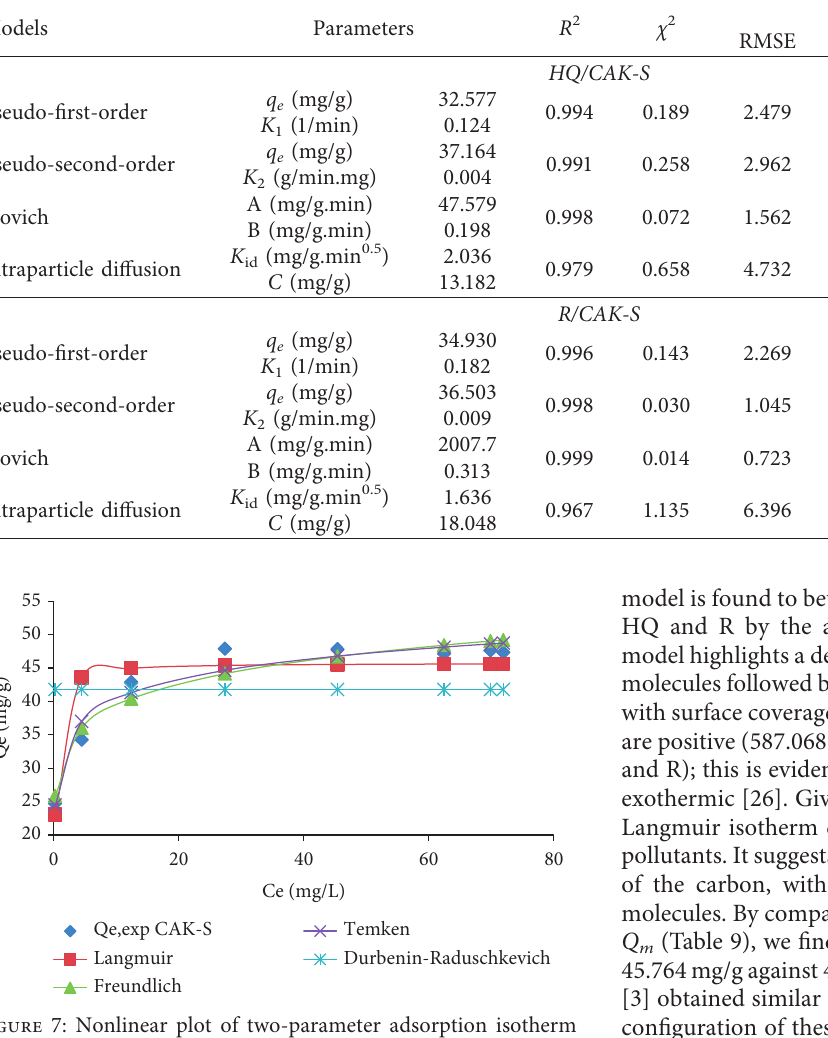
Table 8: Kinetic data obtained by nonlinear fitting analysis (see equations in Table 3 and 4).